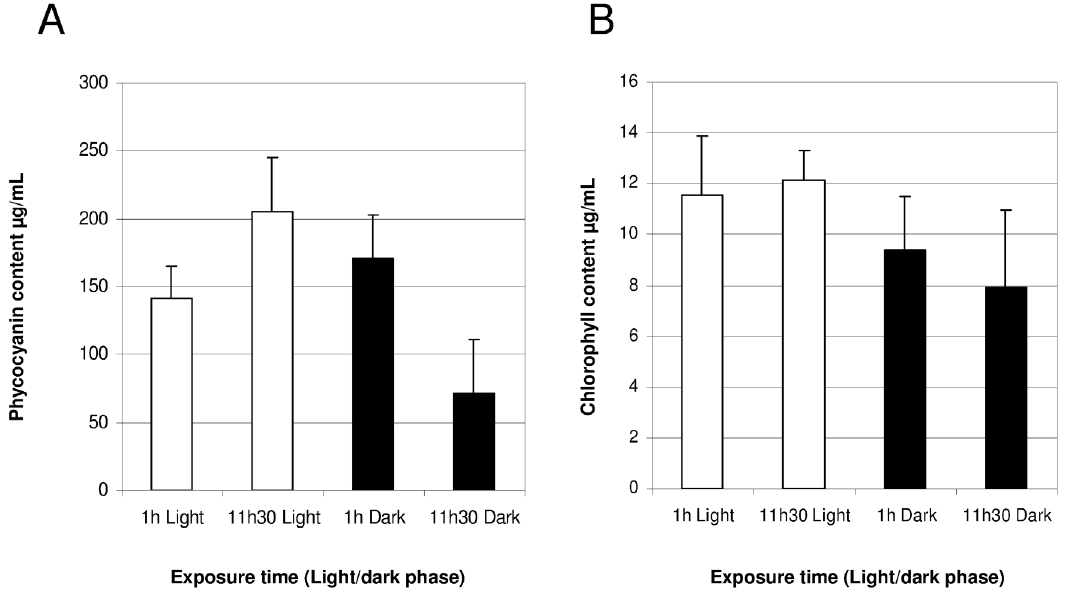
Figure 6. Phycocyanin (A) and chlorophyll content (B) according to two different time points of the light (white bars) and dark phases (black bars).